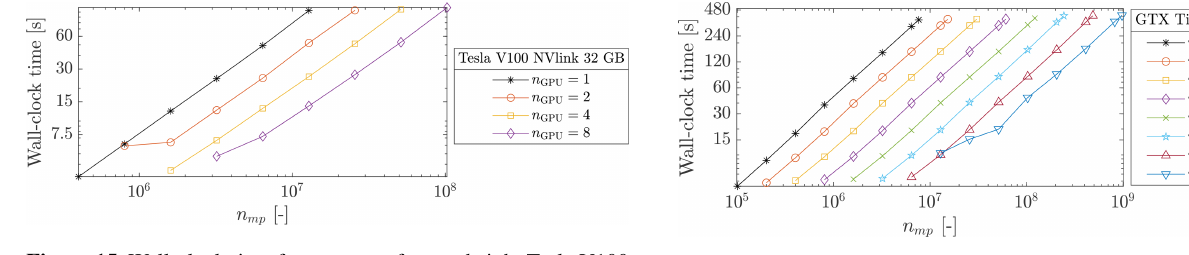
Figure 17. Wall-clock time reported for up to 128 Geforce GTX Titan X GPUs and up to n mp ≈ 9.75 × 10 8 .